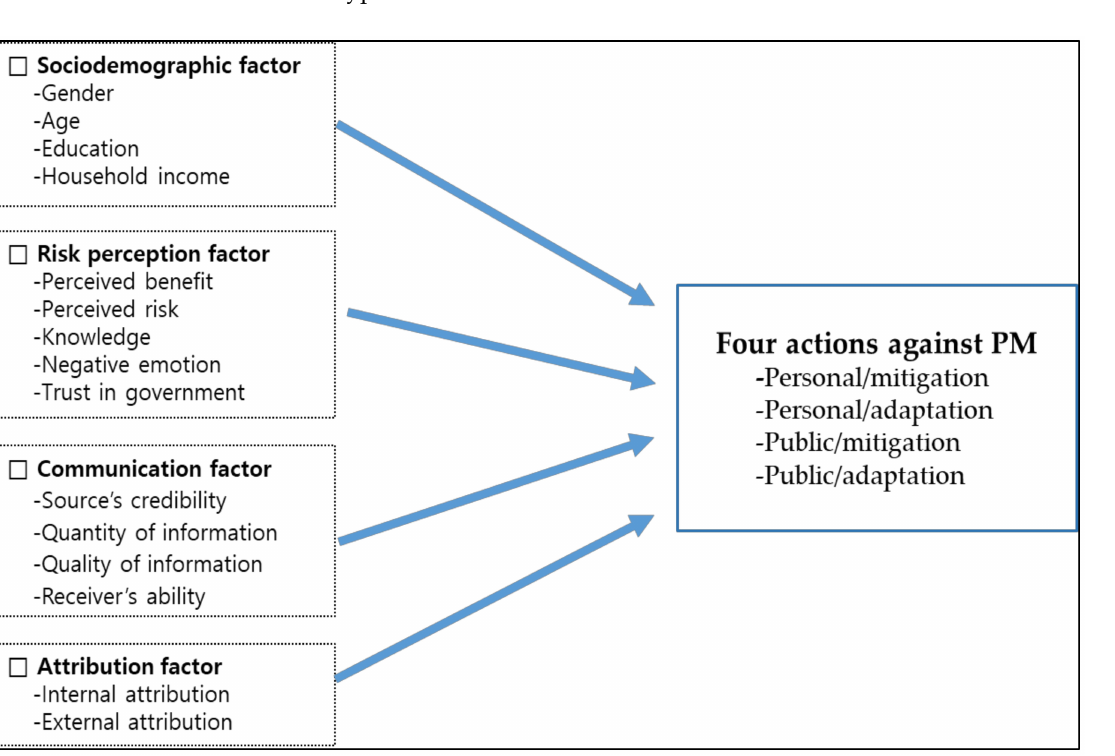
Figure 2. Research